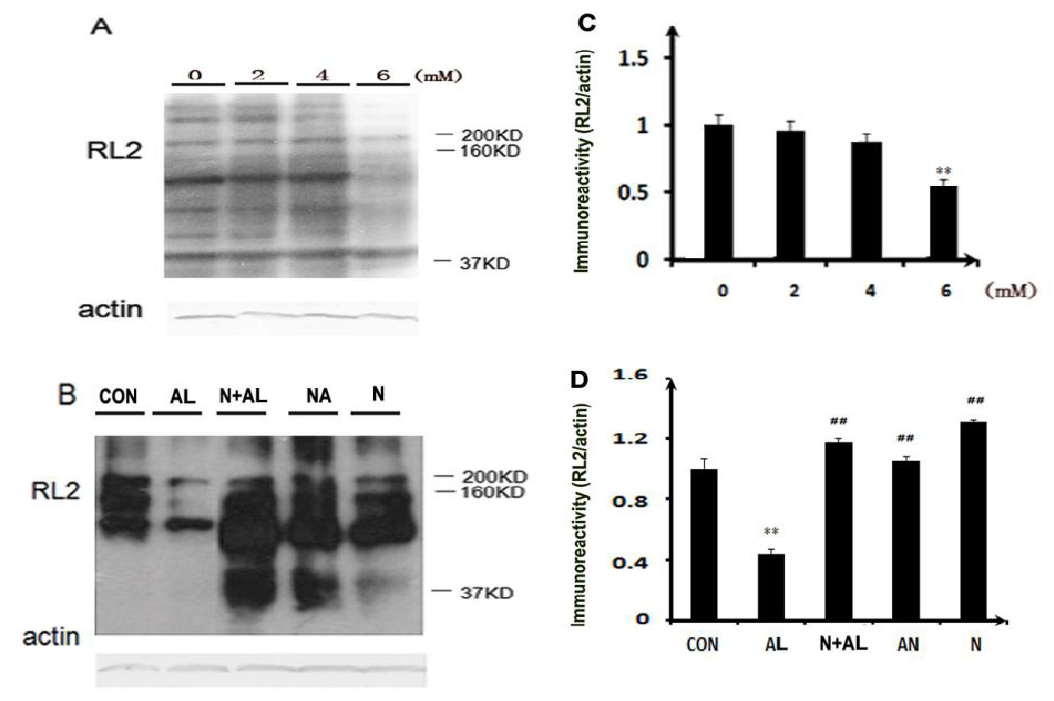
Fig. 1. The O-GlcNAc in alloxan or/and NAG-Ae treated SK-N-SH cells. A. Representative blots of cells treated with different concentration of alloxan (AL) (0, 2, 4, 6 mM) and with specific monoclonal antibodies of RL2 and actin recognized the O-Glycosylation and β-actin. B. Representative O-GlcNac blots of cells pretreatment with 20 µM NAG-Ae (N+AL) or treated with 20 μM NAG-Ae and 6mM alloxan (NA) at the same time with antibodies RL2 and β-actin. C. and D. The quantities assay of blot A. and B. **indicated P <0.01 compared to the control cells. ## P <0.01 compared to alloxan treated cells for the same treatment